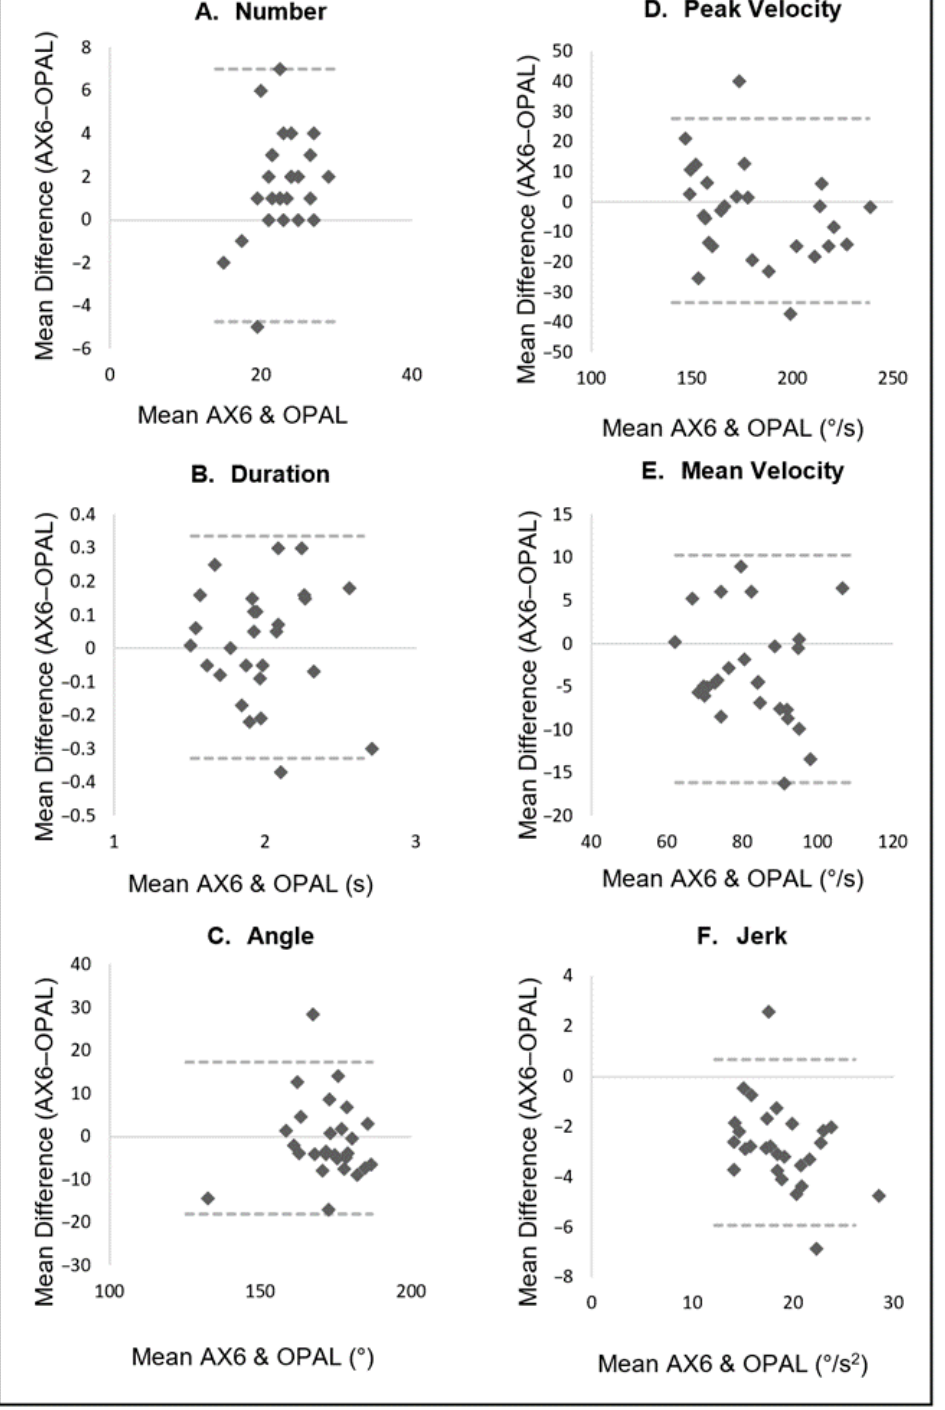
Figure 4. Two-Minute Walk task: Bland – Altman plots displaying agreement between AX6 and